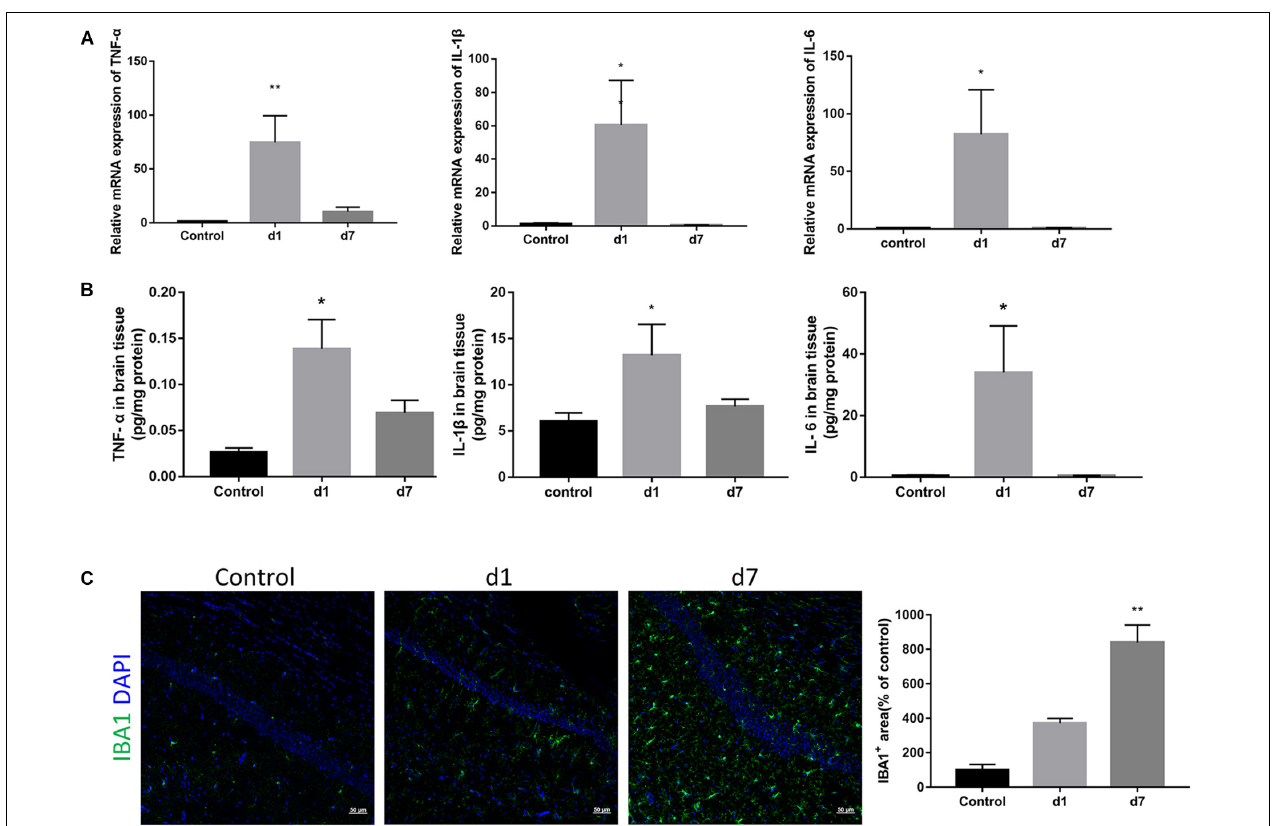
FIGURE 3 | Effects of LPS on the expression of pro-inflammatory cytokines and microglia in the brain. (A) The relative mRNA expression of proinflammatory cytokines TNF- α , IL-1 β , and IL-6 in the brains of the control and LPS-injected mice were determined by qPCR assay ( n = 6). (B) Protein levels of TNF- α , IL-1 β , and IL-6 in brain homogenate from the two groups were determined by ELISA ( n = 4). (C) Immunostaining and relative quantification of IBA1 specifically expressed in macrophages/microglia. Brain tissues were obtained from the control mice and mice administered with LPS on the first day and after 7 days ( n = 3). ∗ P < 0.05, ∗∗ P < 0.01 vs. control, by one-way